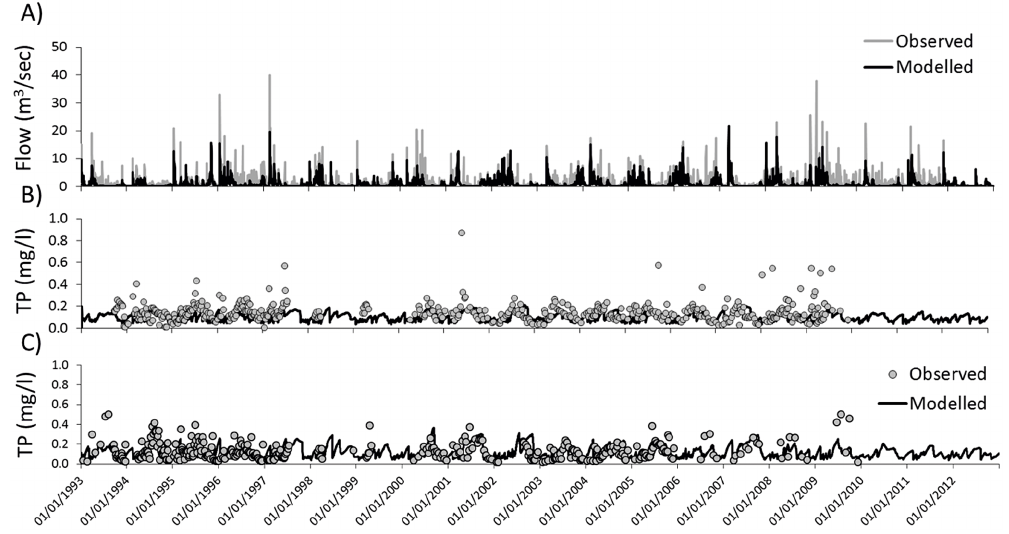
Figure 5. Example of INCA model output. Calibration results from Holland River comparing modelled and observed data of (a) flow at East